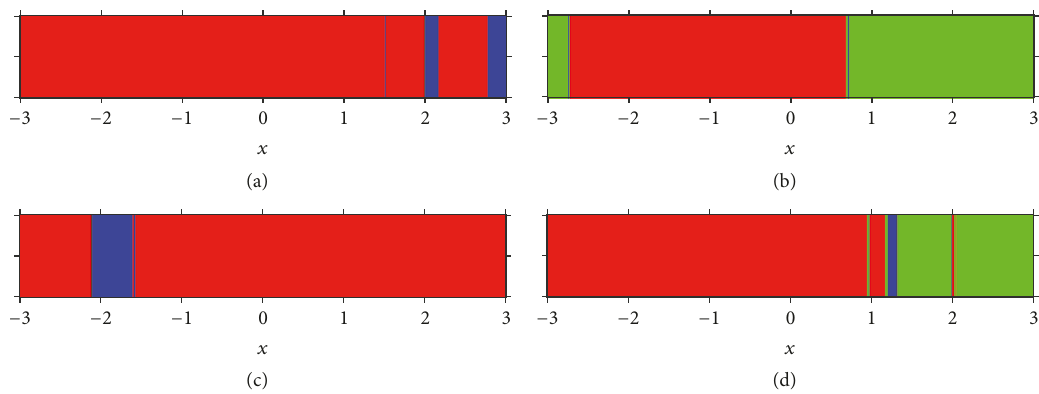
Figure 9: Dynamical lines of methods with (a) (𝛼,𝛾) = (0.1124,−1) , (b) (𝛼,𝛾) = (−2,0.5) , (c) (𝛼,𝛾) = (1, 1) , and (d) (𝛼,𝛾) = (−0.23, −1.5) (red: 𝑥 ∗ 1 , green: 𝑥 ∗ 2 , blue: 𝑥 ∗ ∞ , and black: